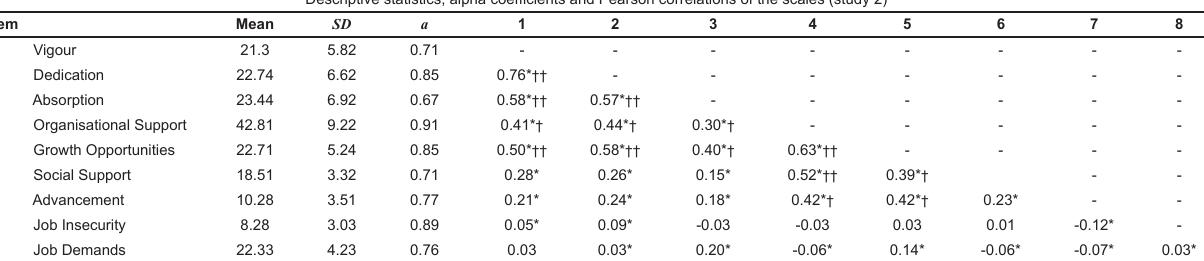
TABLE 6 Descriptive statistics, alpha coefficients and Pearson correlations of the scales (study